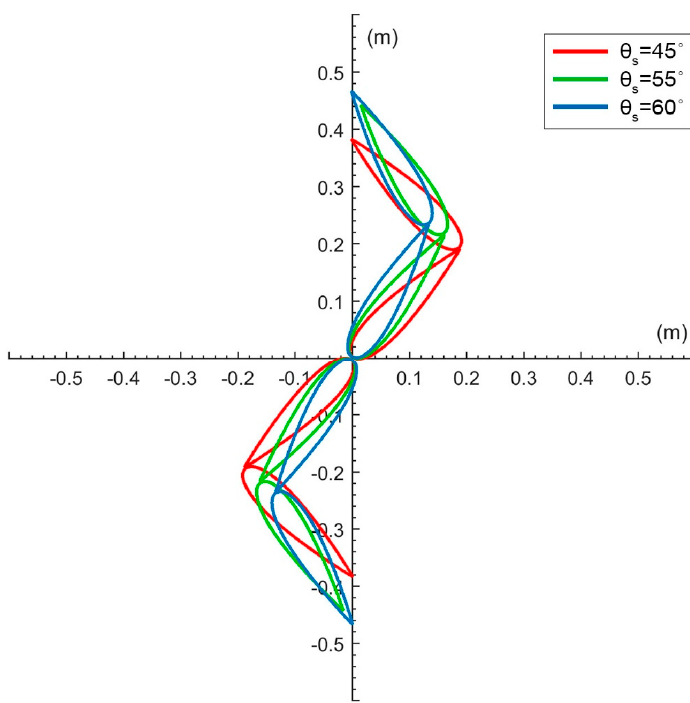
Figure 2. E ff ect of varying the angle ( θ s ) on the geometric orientation of the Savonius rotor shape.